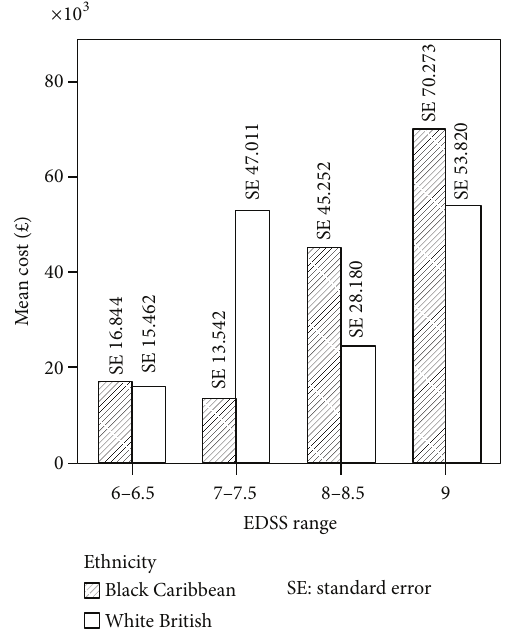
Figure 2: The mean cost in each EDSS group for Black Caribbean and White British